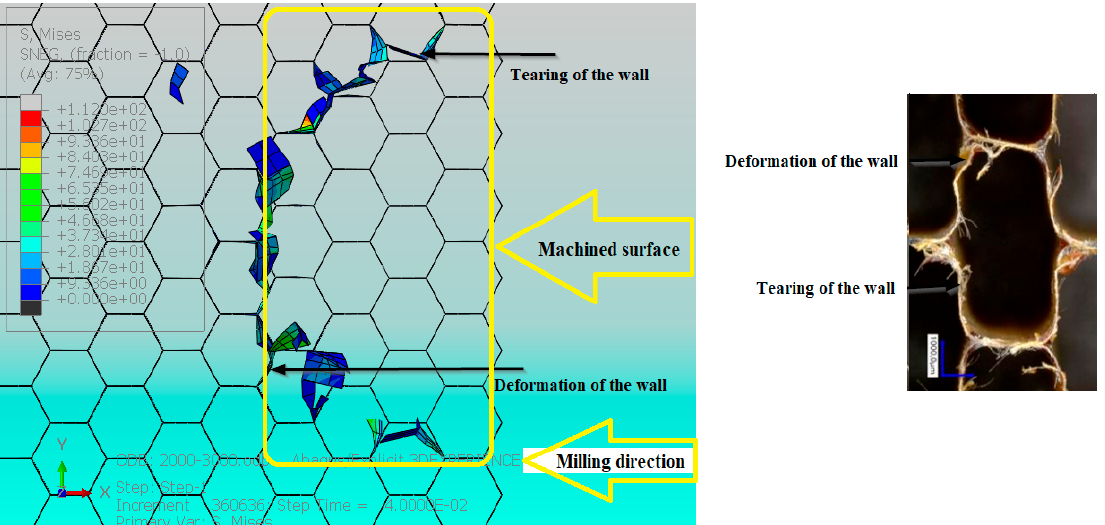
Figure 9. Comparison between the surface quality resulting from the numerical simulation and the surface quality determined from the experiment. The cutting conditions: 3000 mm/min and 2000 rpm.